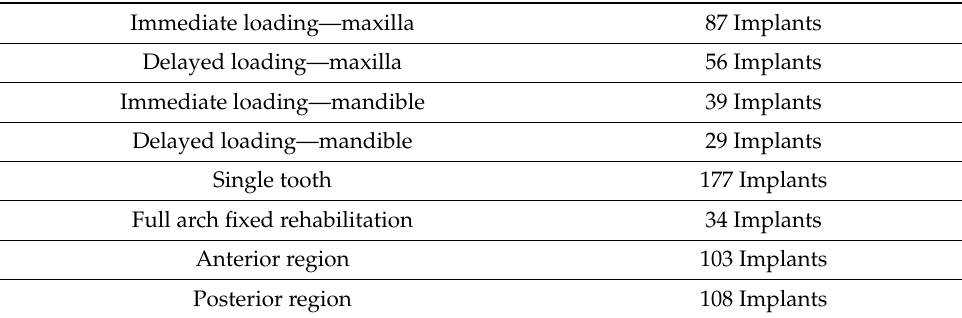
Table 3. Distribution of the dental implants by region and load